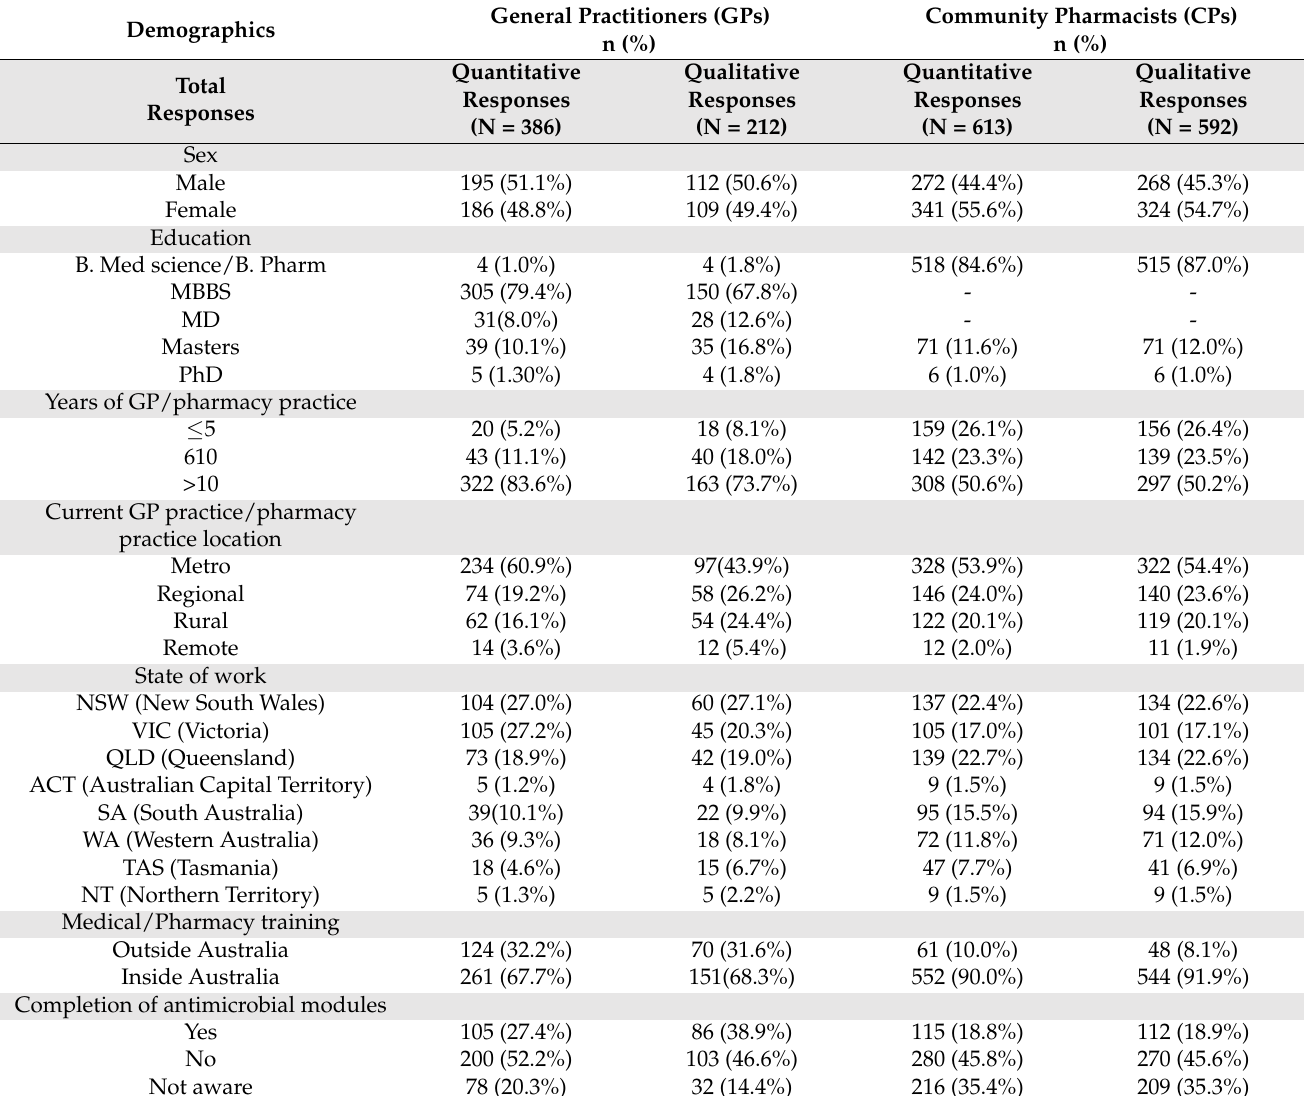
Table 1. Demographics of survey participants responded to quantitative and open-ended